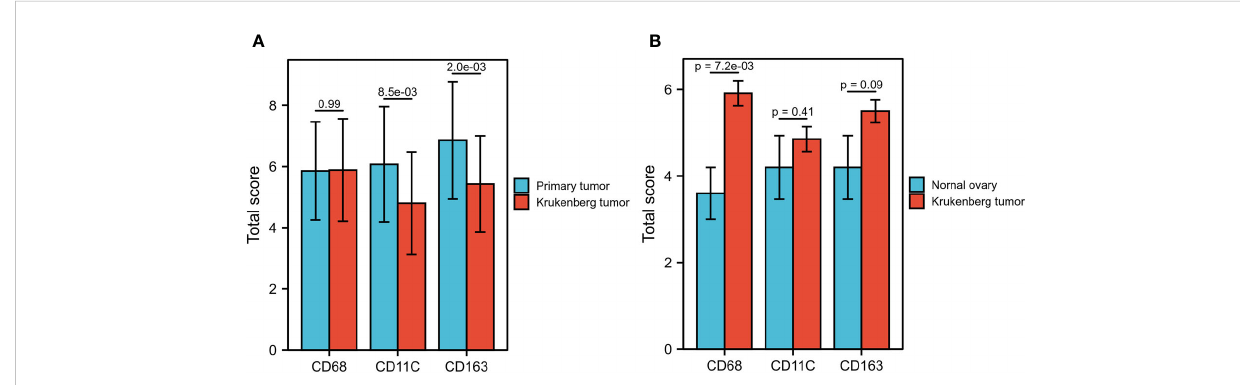
FIGURE 4 Comparison of CD68+, CD11c+, and CD163+ TAM scores between primary tumors, KT tissues, and prophylactically resected ovarian tissues. (A) The total score of CD11c+ and CD163+ TAMs in primary tumors was signi fi cantly higher than that in KT tissues (P = 8.5E-03, P = 2.0E-03), whereas no signi fi cant difference was observed in the total score of CD68+ TAMs (P = 0.99). (B) The total score of CD68+ TAMs in KT tissues was signi fi cantly higher than that in prophylactically resected ovarian tissues (P = 7.02-03), whereas no signi fi cant difference was observed in the total score of CD11c+ and CD163+ TAMs (P = 0.41, P =